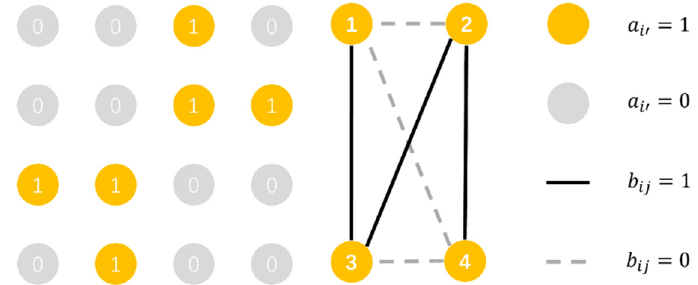
Figure 4. An example of undirected and unweighted graph.